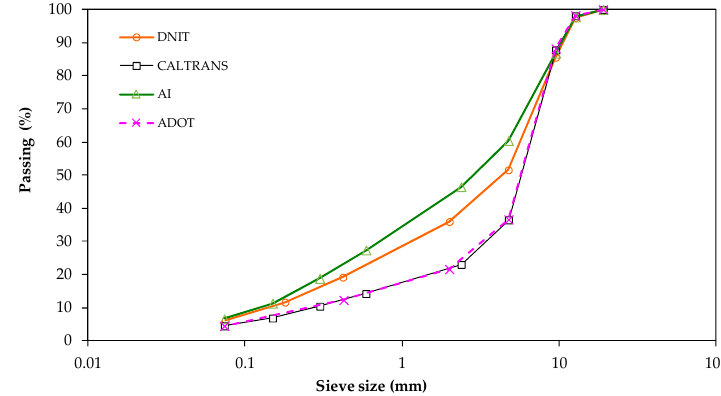
Figure 4. Mixtures’ gradation curves.